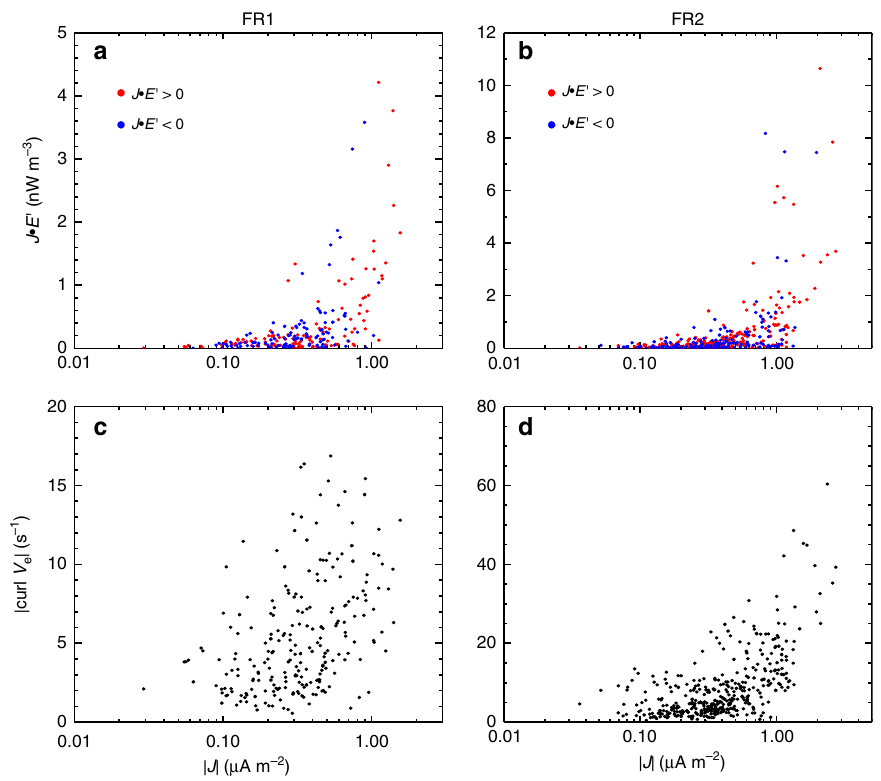
Fig. 3 The scatter plots of J • E ′ , | ∇ × V e | and | J |. a , b The scatter plot of J • E ′ and current density intensity | J | inside FR1 and FR2. The red (blue) dots represent the positive (negative) J • E ′ data points. c , d The scatter plot of intensity of the electron velocity curl and | J | inside FR1 and